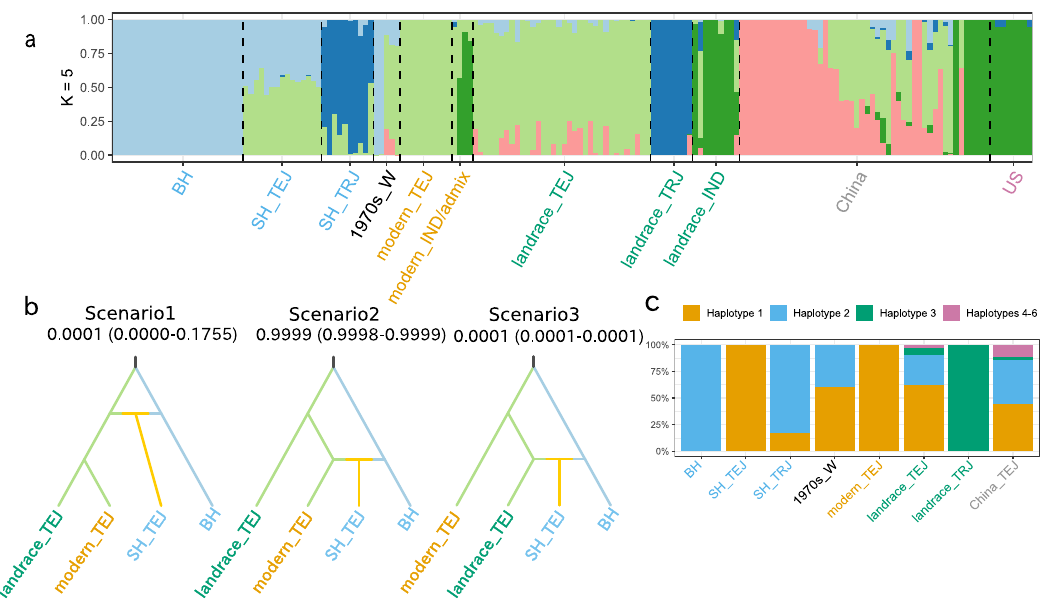
Fig. 2 Origin of Japanese weedy rice. a Population structure of weedy and cultivated rice strains. Ancestry proportions for individuals with K = 5 are presented. b Demographic scenario models involving BH and SH_TEJ weedy rice and modern and landrace cultivated rice for deducing the hybridization history of SH weedy rice. Scenario 1: SH weedy rice evolved from a hybridization event between BH weedy rice and cultivated rice before the divergence of modern and landrace strains; Scenario 2: it evolved from a hybridization event between BH weedy and modern cultivated rice; and Scenario 3: it evolved from a hybridization event between BH weedy and landrace cultivated rice. Posterior Probability (95% of con fi dence interval) for each scenario was indicated under the title of each scenario. c Relative frequency of chloroplast genome haplotypes in weedy and cultivated rice groups. Variants of each of the chloroplast genome haplotypes are indicated in Supplementary Table